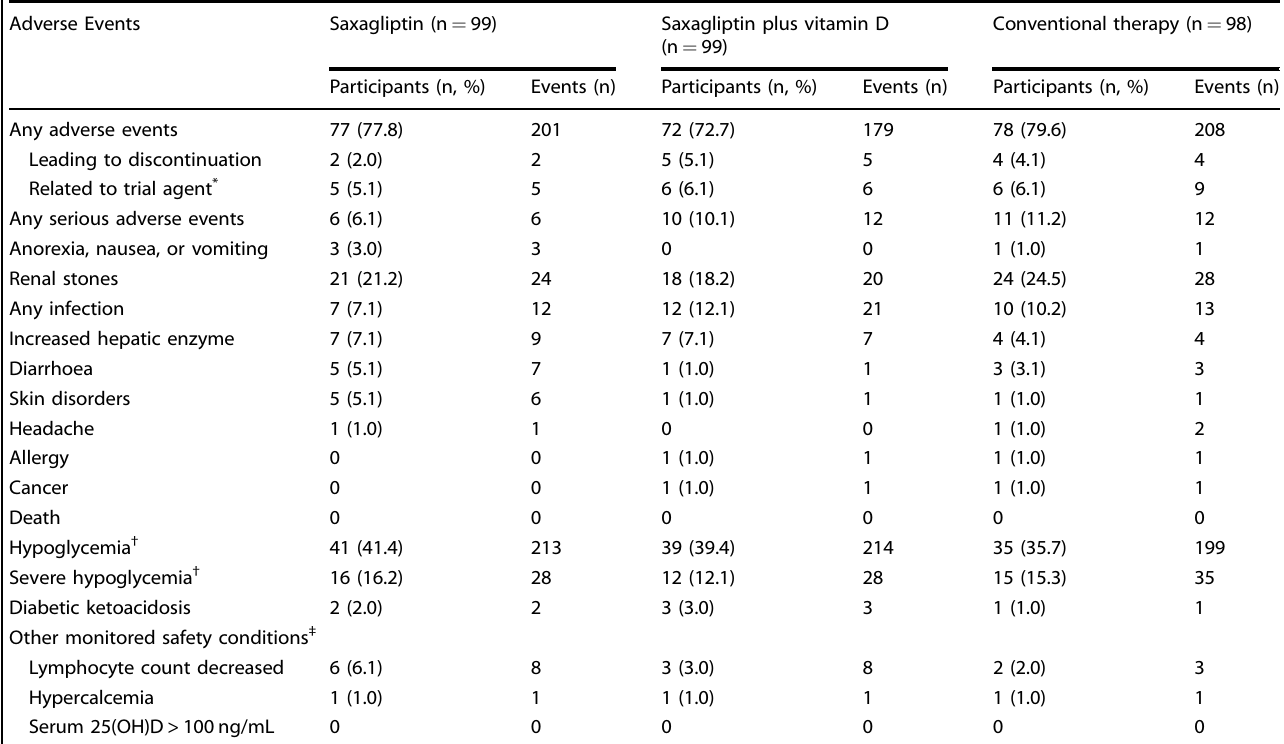
Table 2. Adverse Events (Safety Analysis